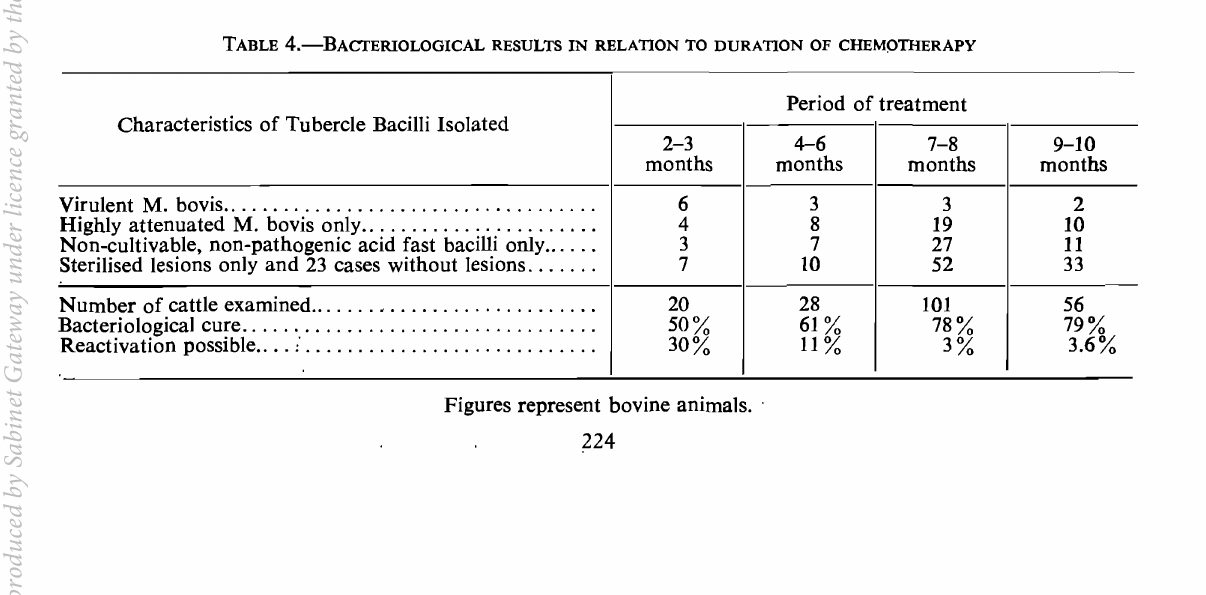
TABLE 4.-BACTERIOLOGICAL RESULTS IN RELATION TO DURATION OF